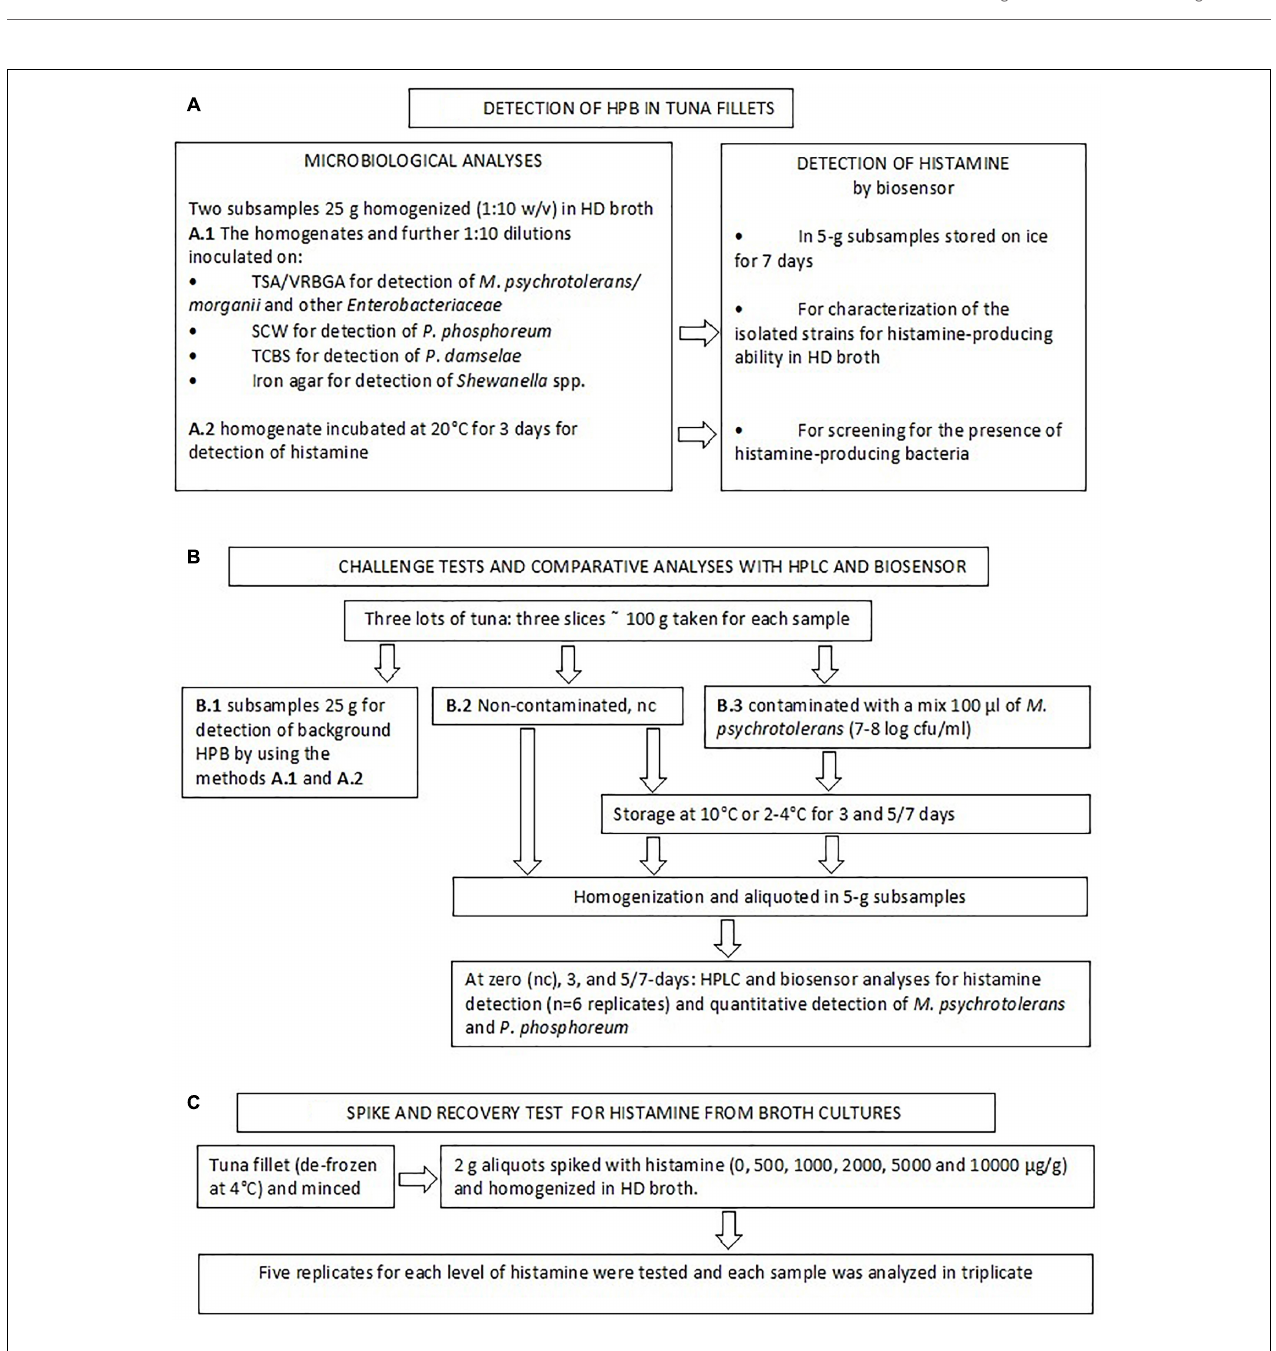
FIGURE 1 | Flow diagram describing the study